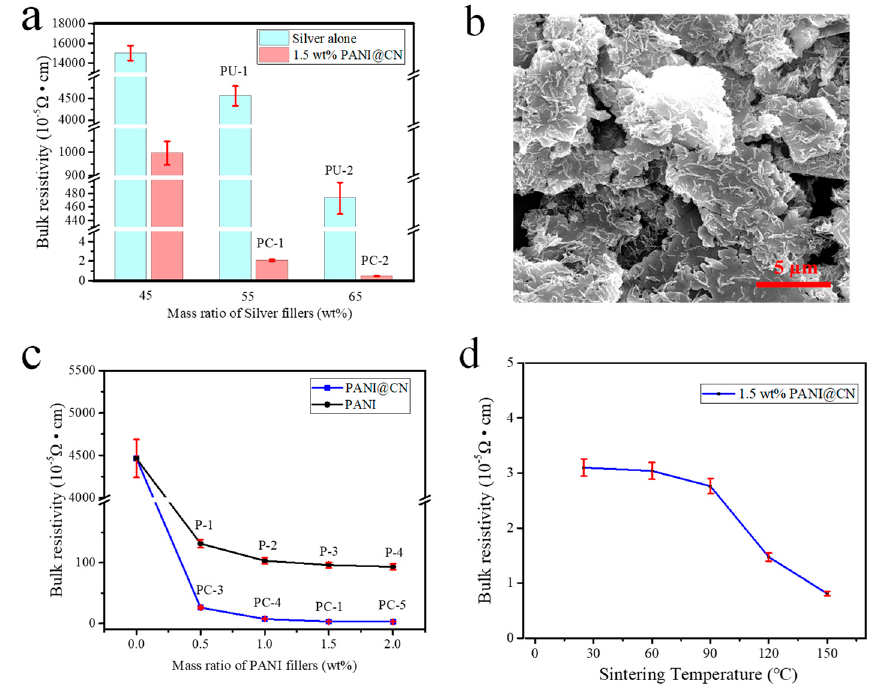
Figure 6. ( a ) Bulk resistivity of the ECAs with different silver content, ( b ) SEM images of PC- -1ECAs, ( c ) bulk resistivity of hybrid ECAs containing 55 wt% Ag fillers (PC-1, 3, 4, 5; P-1, 2, 3, 4) as a function of different PANI and PANI@CNs, and ( d ) the hybrid ECAs (PC-1) curing at different temperatures.